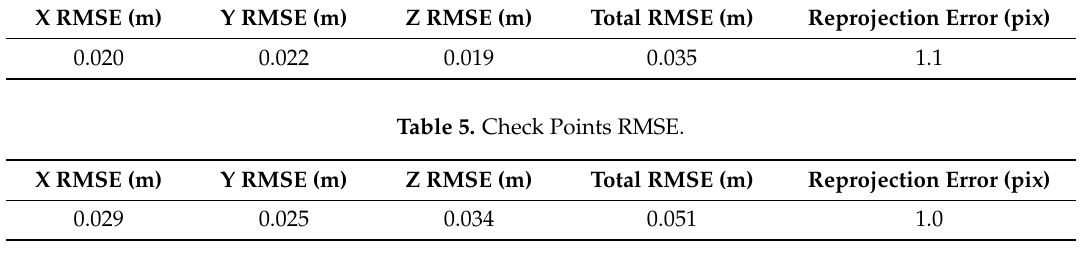
Table 6. Error values of camera position measurements by Global Navigation Satellite System (GNSS) system mounted on the UAV.